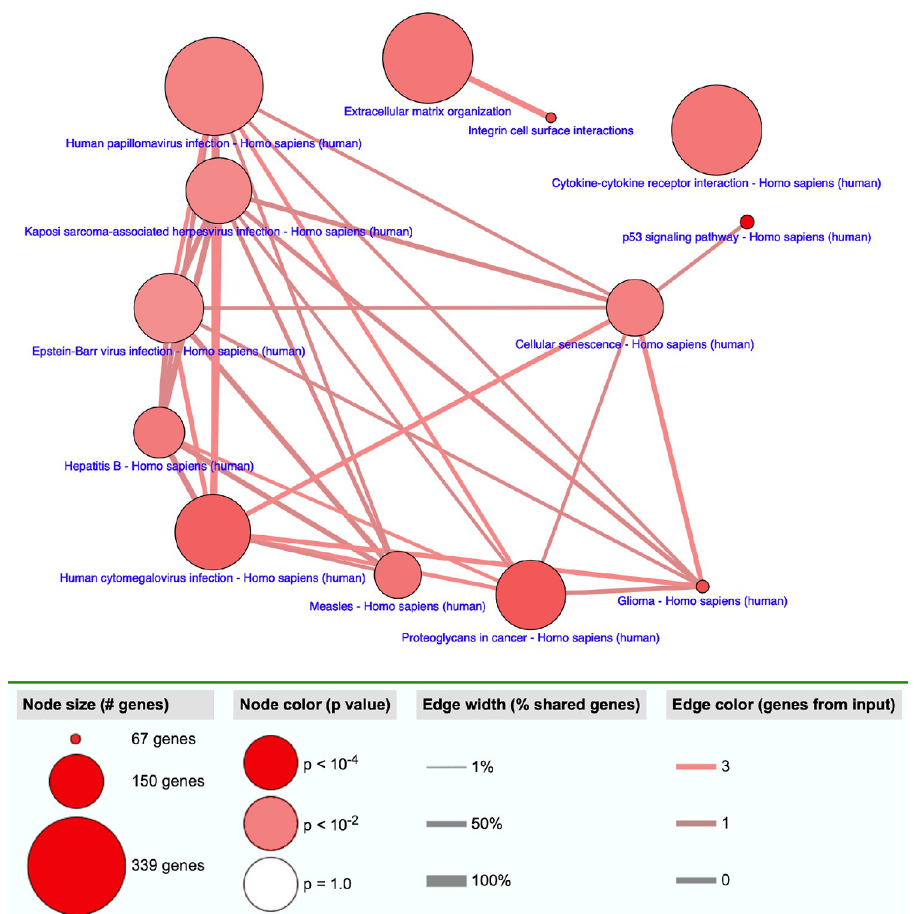
Fig 4. Over representation analysis using CPDB.org incorporating 35 genes associated with sinusoidal obstruction syndrome identified through a combined test statistic.